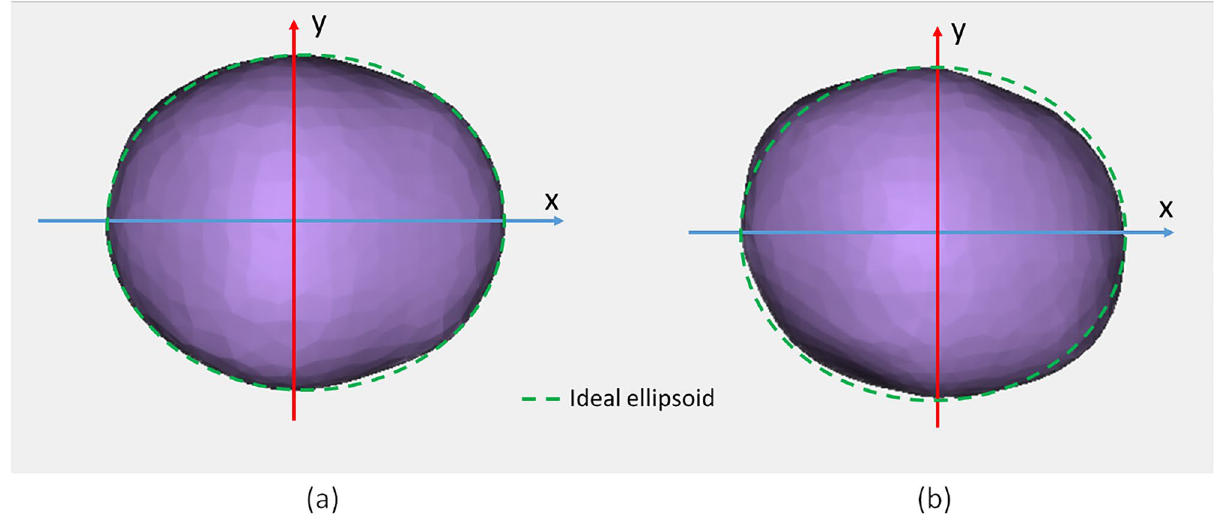
Figure 1. Visualization of lheads’ 3D model with the ideal fitted ellipsoid section on top: ( a ) regular patient (ID: H1, Table 1); ( b ) patient with DP (ID: P01, Table